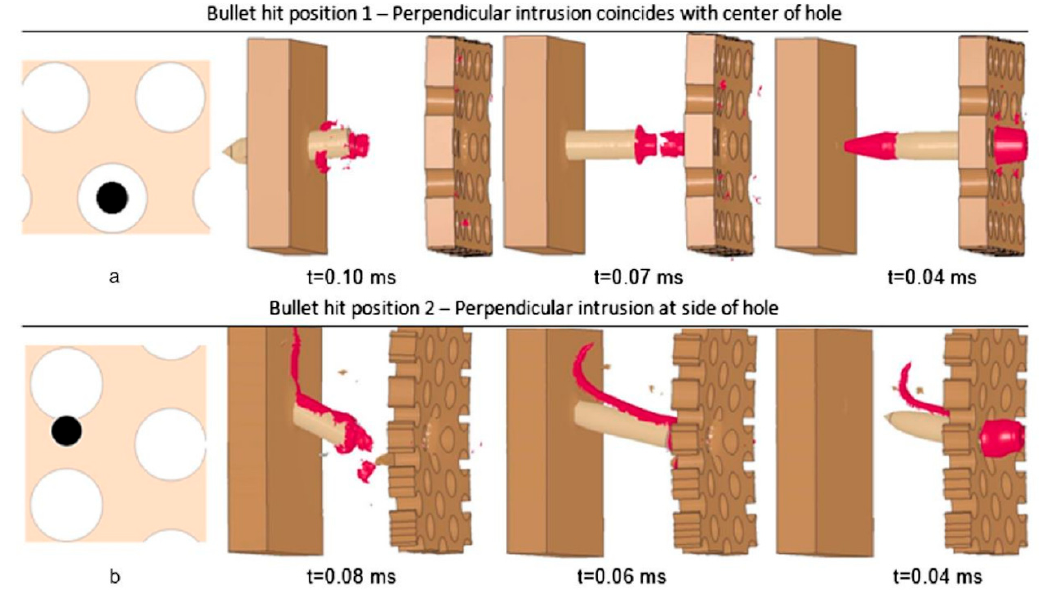
Figure 2. Penetration/perforation sequences from numerical simulations of 7.62 × 54 mm AP projectiles striking base armour plates. ( a ) At the centre of a hole, ( b ) at the side of a hole [6].